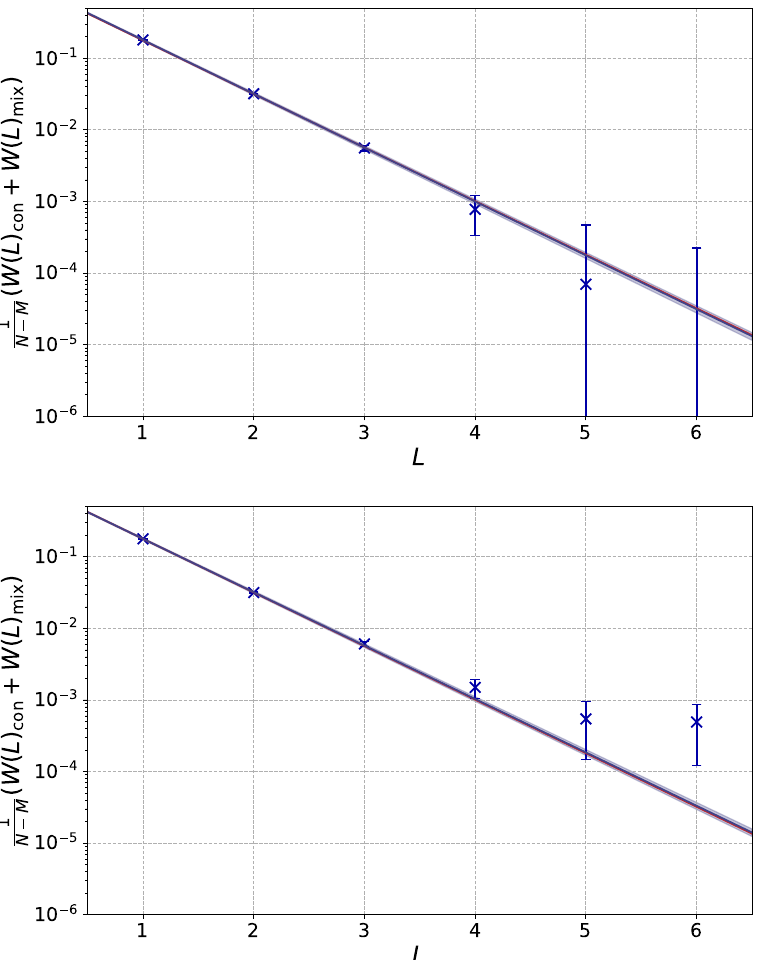
Figure 10. Combined mixed and confined subsector Wilson loop, W con + W mix , at T = 0 . 29 , for P = 0 . 2 and P = 0 . 25 , respectively. We have extrapolated to the large N limit using N = 24 , 32 , 64 , and to the continuum limit using n t = 16 , 24 , 32 for each N , using the 2D interpolation 1 ( W con + W mix )( L ) = γ ( L ) + β 1 + β 2 + β 2 . We fitted these interpolated values γ ( L ) for M − N N 2 n t n t N 2 1 ≤ L ≤ 4 to the ansatz γ ( L ) = exp( − cL + d ) . We obtained c = 1 . 733(19) and d = 0 . 021(22) for P = 0 . 20 , and c = 1 . 718(18) and d = − 0 . 006(21) for P = 0 . 25 . The fit is shown along with error bounds by the blue line. The theoretical prediction is shown by the red and is mostly obscured by the